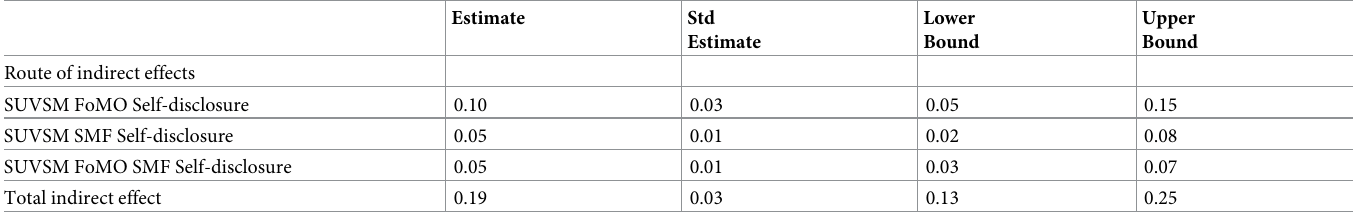
Table 3. Indirect effects of SUVSW predicting self-disclosure via FoMO and